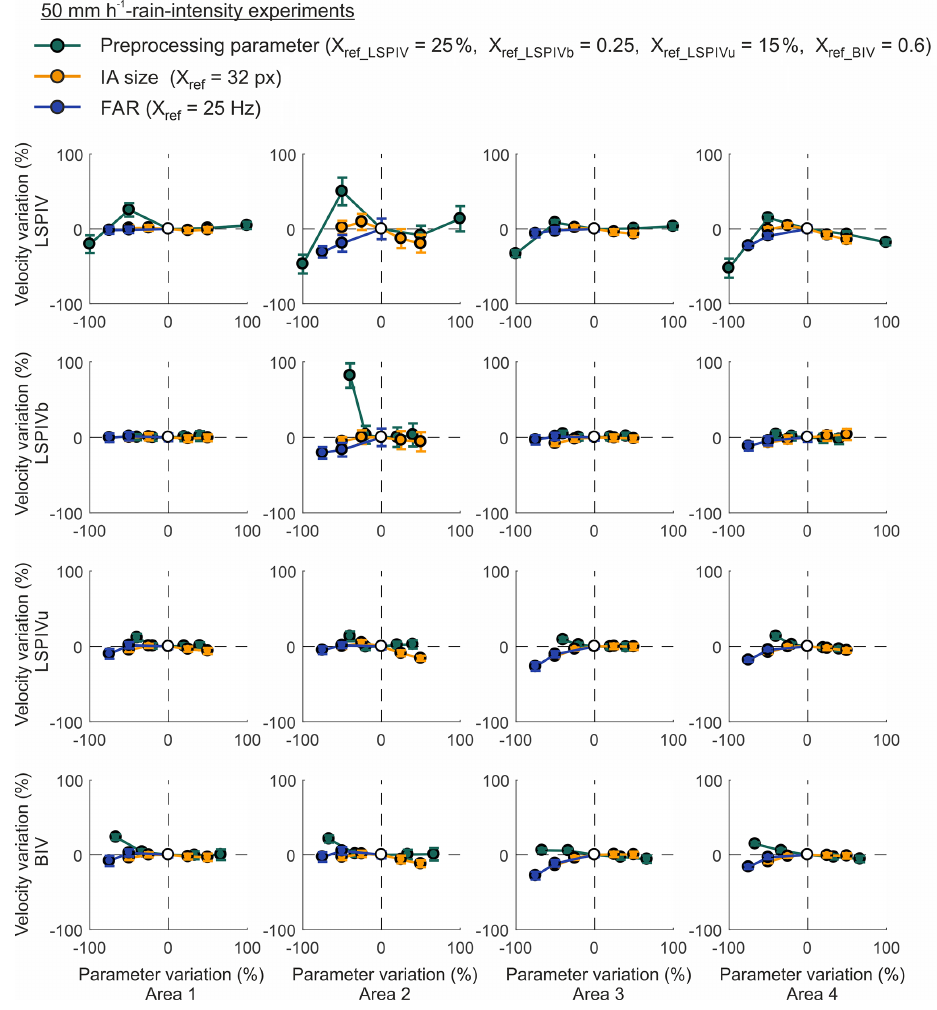
Figure 5. Percentage of variation in the mean velocities when varying parameters of the analysis for the four studied areas (columns) and the four imaging velocimetry techniques considered (rows) in the case of 50mmh − 1 rainfall. Mean velocity variability for the different pairs of frames analyzed is included using